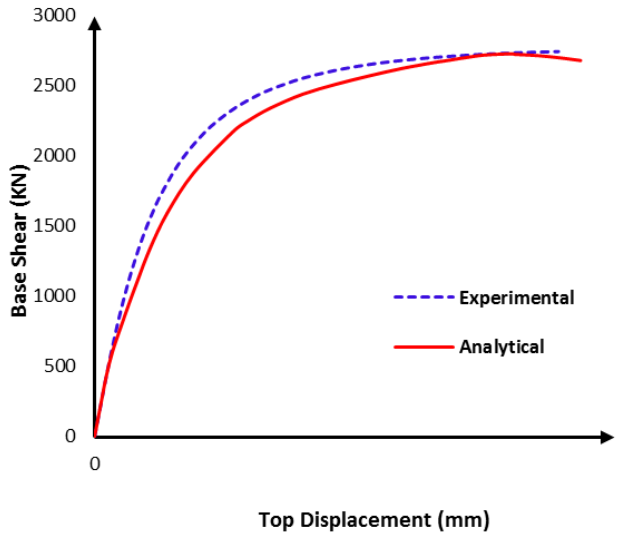
Figure 3. Comparison of Experimental and analytical load-displacement curves of specimen.